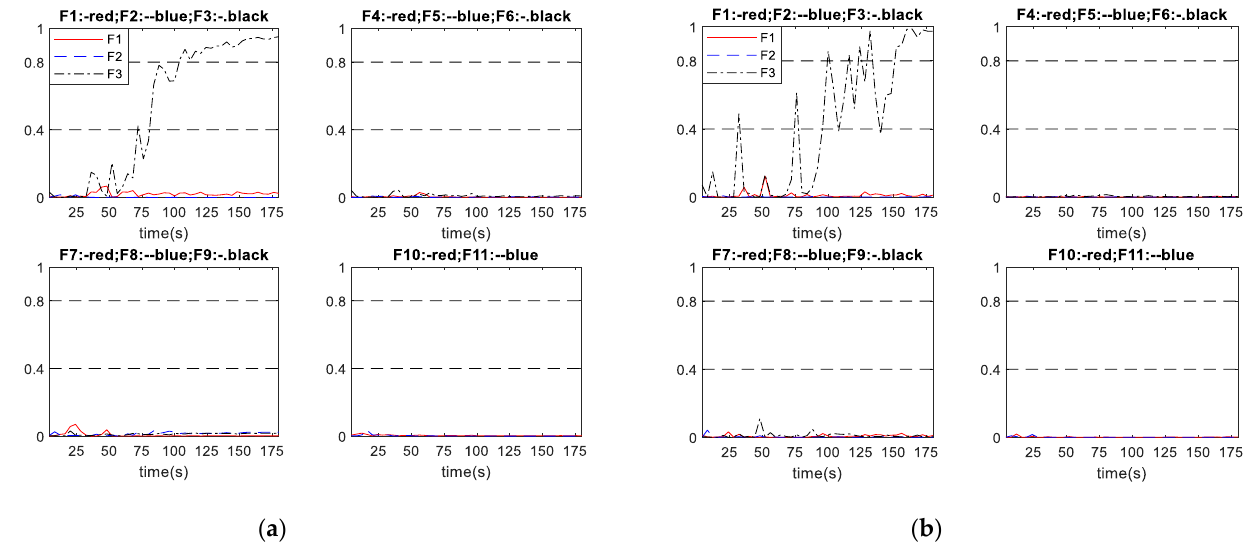
Figure 10. Diagnosis performance of scheme A ( a ) and scheme B ( b ) under incipient fault No. 3 with developing speed of −1.29 × 10 −4 (s −1 ).